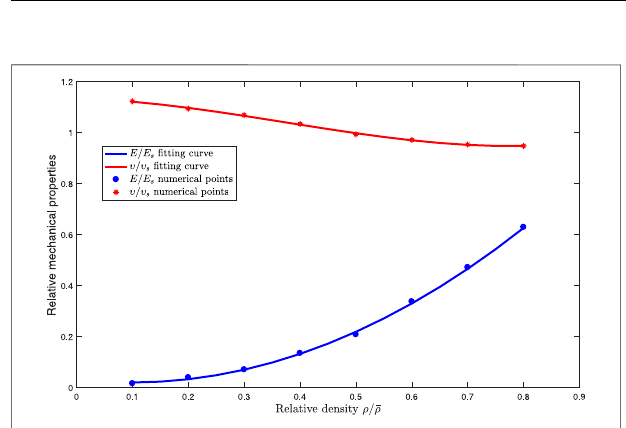
FIGURE 7 | Fitting function curves and discrete numerical points of effective properties with respect to relative density of octet-truss cells.